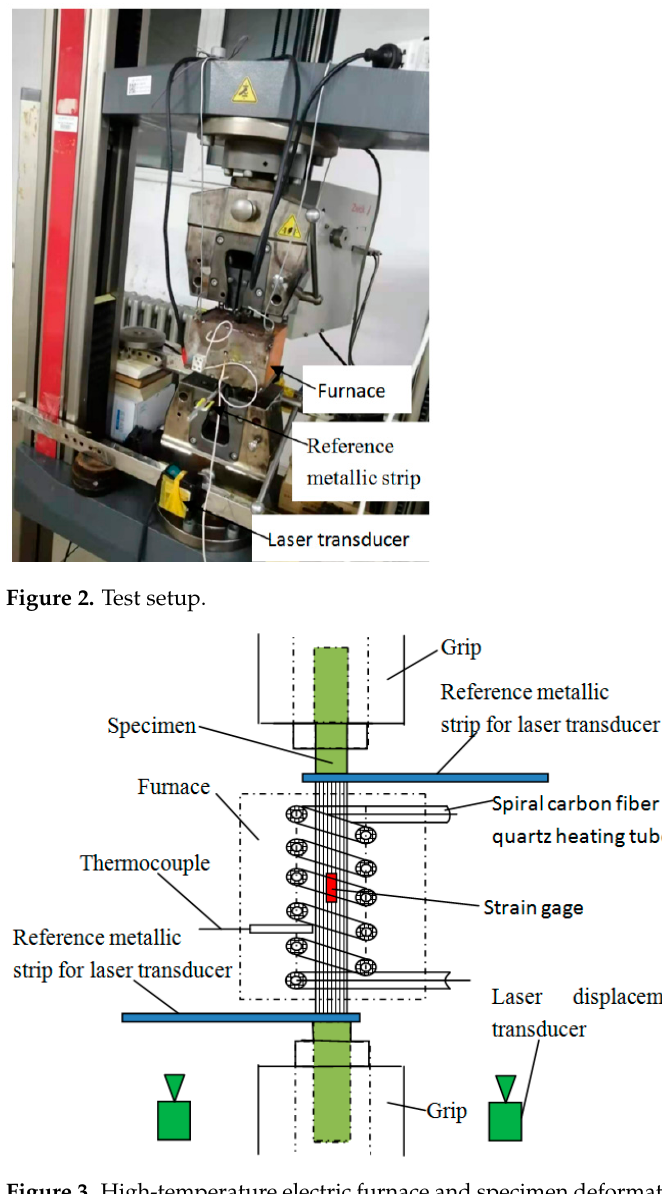
Figure 4. The typical results of displacement of testing machine and laser transducers. 3. Test Results 3.1. Strength and Elastic Modulus Experimental results of the five repeated tests are listed in Tables 3 and 4. According to ASTM D 3039/D 3039M-08 [22], the tensile strength and modulus of the tested CFRP laminate were calculated. Taking the data acquired at room temperature as the bench- mark, the degradation ratio of the tensile strength and modulus are listed as well. The failure modes after the tests were observed and are categorized in the tables. At room 0